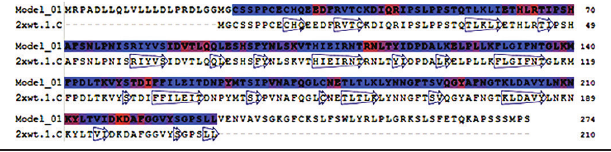
figurE 19 − TSHR [ Homo sapiens ] – model – template alignment TSHR: thyroid-stimulating hormone receptor.